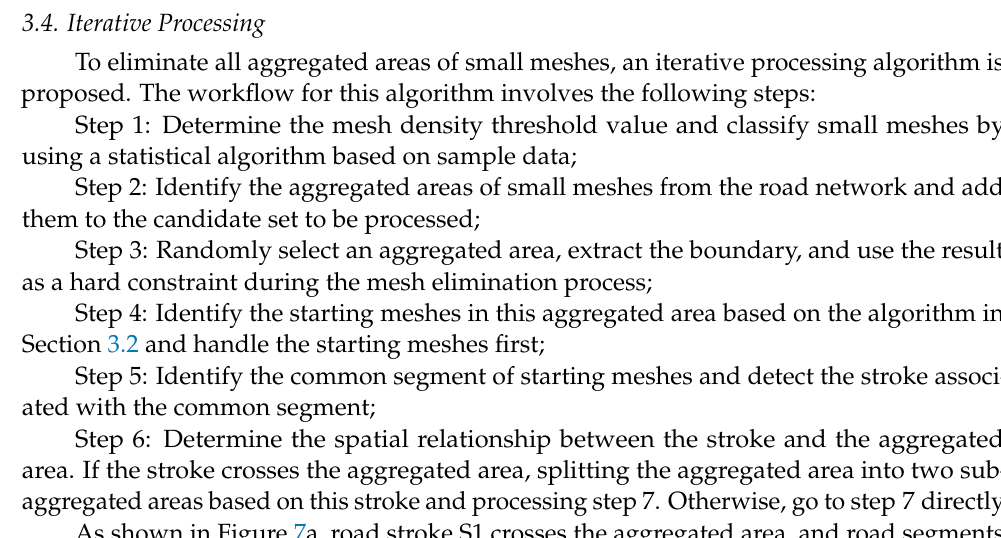
Figure 6. Schematic diagram of the ordinal elimination algorithm: ( a ) original road network; ( b ) starting meshes and the stroke for their common segment; ( c ) the elimination result based on the stroke connection order; and ( d ) the elimination result based on the mesh density in descending order.